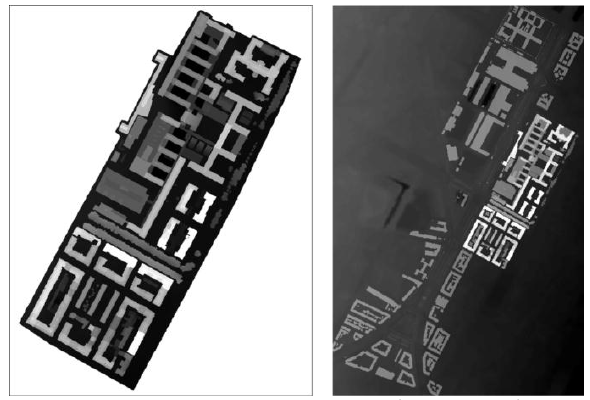
Figure 4. Example of integration DSM (grid = 20 cm); its integration in the DSM of the road infrastructure